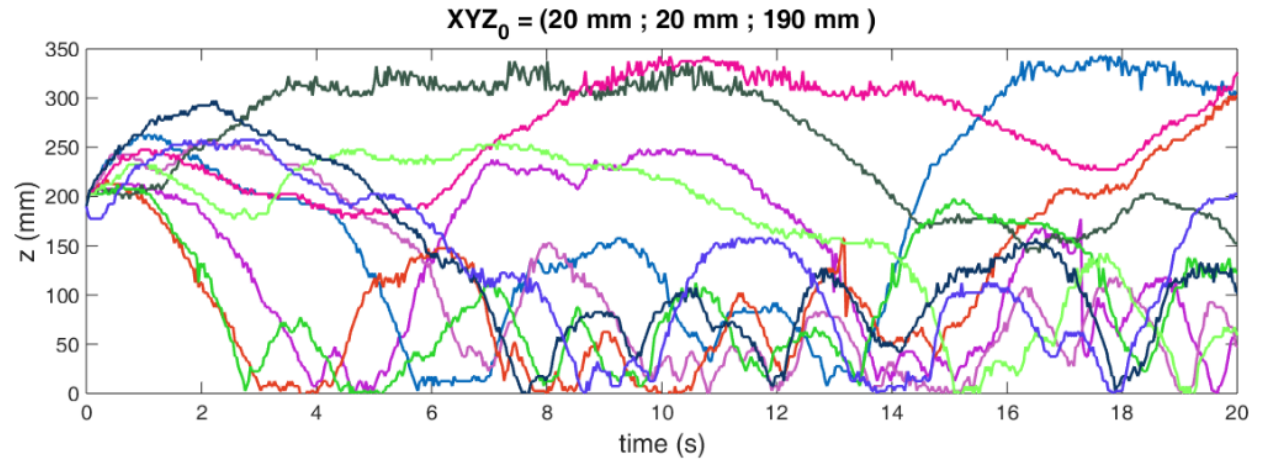
Figure 2 . Axial projection of a trajectories manifold, obtained from GLSFB, starting from a specific voxel.